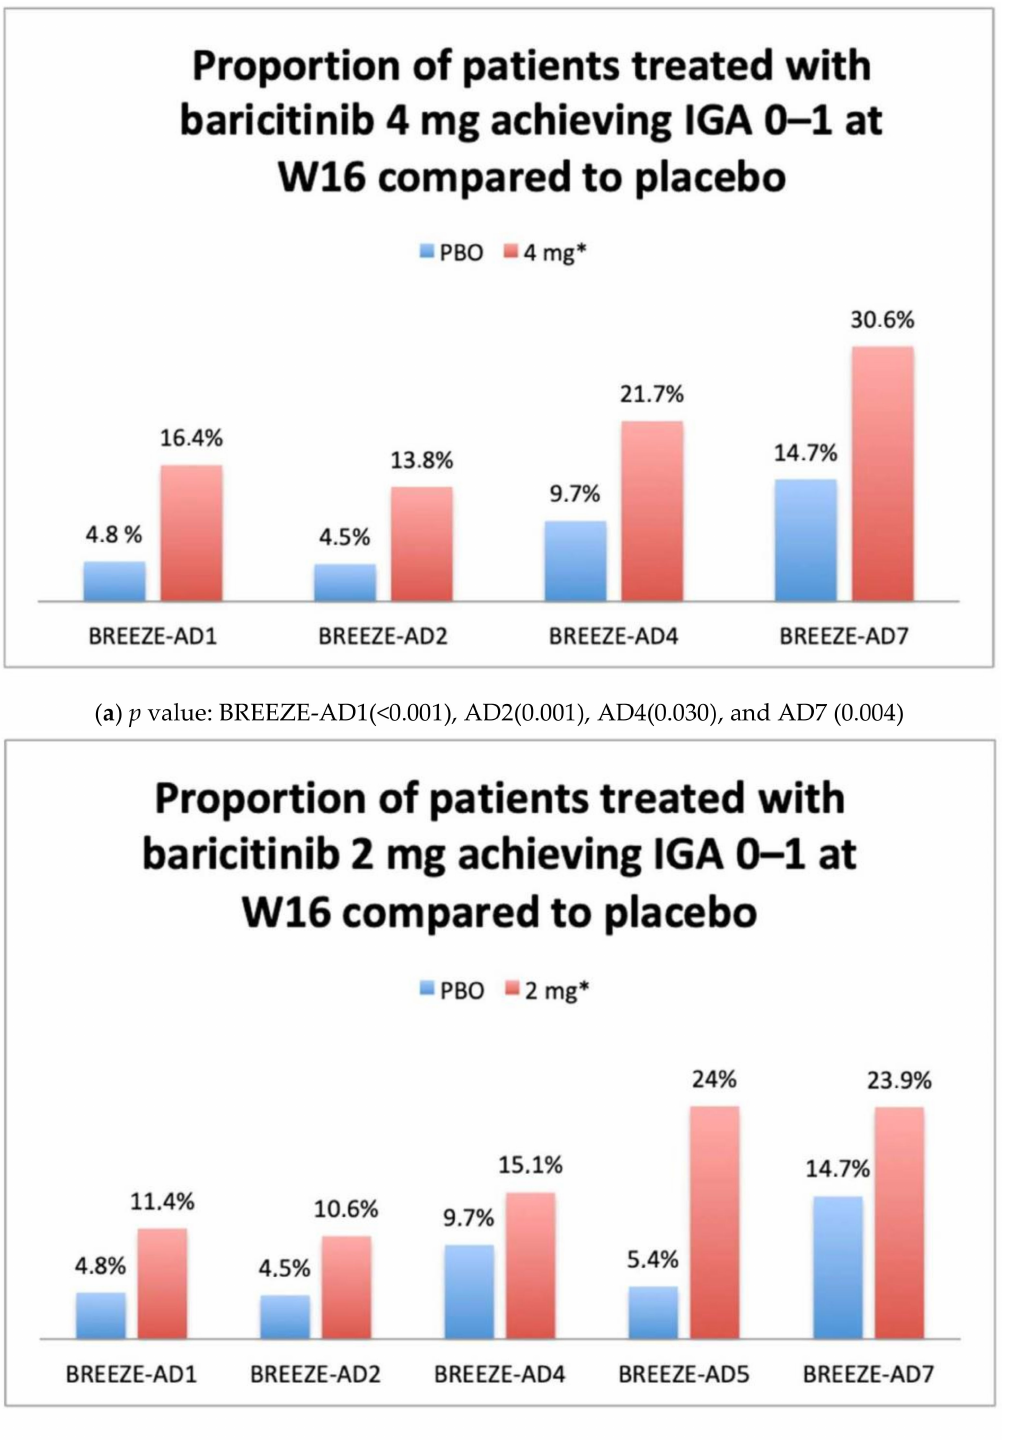
Figure 1. ( a ) Primary efficacy endpoint from BREEZE-AD1, AD2, AD4, and AD7: Proportion of patients treated with baricitinib 4 mg achieving IGA 0–1 at W16 compared to placebo. Abbreviation: PBO, placebo; IGA, investigator global assessment; W16, week 16; Bari, baricitinib: * In BREEZE-AD-4 and AD7, baricitinib was administered in association with topical corticosteroid as for protocol. ( b ) Primary efficacy endpoint from BREEZE-AD1, AD2, AD4, AD5, and AD7: Proportion of patients treated with baricitinib 2 mg achieving IGA 0–1 at W16 compared to placebo. Abbreviation: PBO, placebo; IGA, investigator global assessment; W16, week 16; Bari, baricitinib. * In BREEZE-AD 4 and AD7, baricitinib was administered in association with topical corticosteroid as for